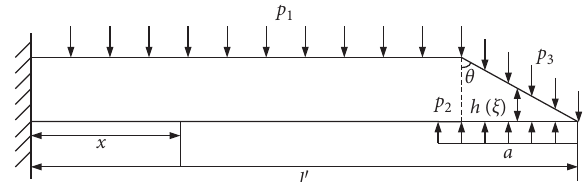
Figure 8: The mechanics model of the forward direction fault.